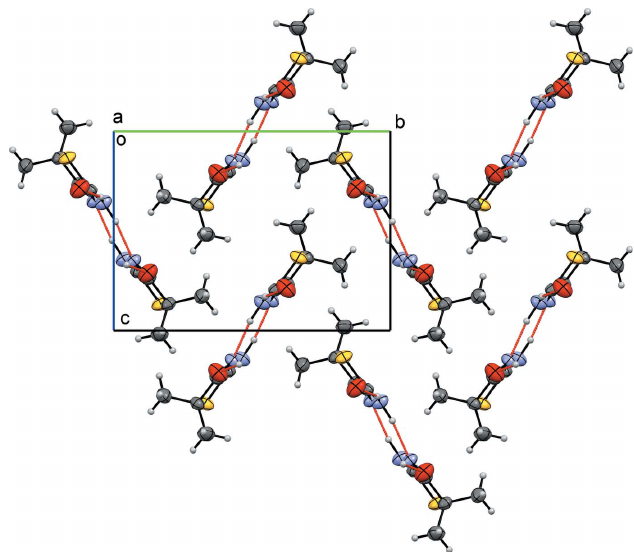
Figure 2 Crystal packing diagram of title compound viewed along [100]. Hydrogen bonds (Table 1) are colored red.